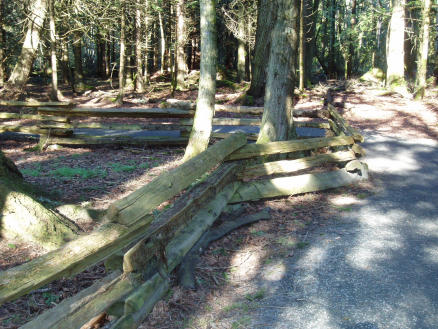
A Fence Protecting the Riparian AreaDue to the environmental movement, to which three classes of seventh-grade students actively contributed, the community has changed both physically and in its attitudes toward the environment.